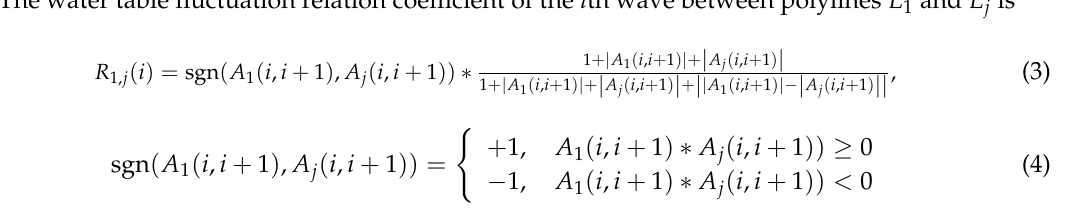
j in a two-dimensional Cartesian coordinate